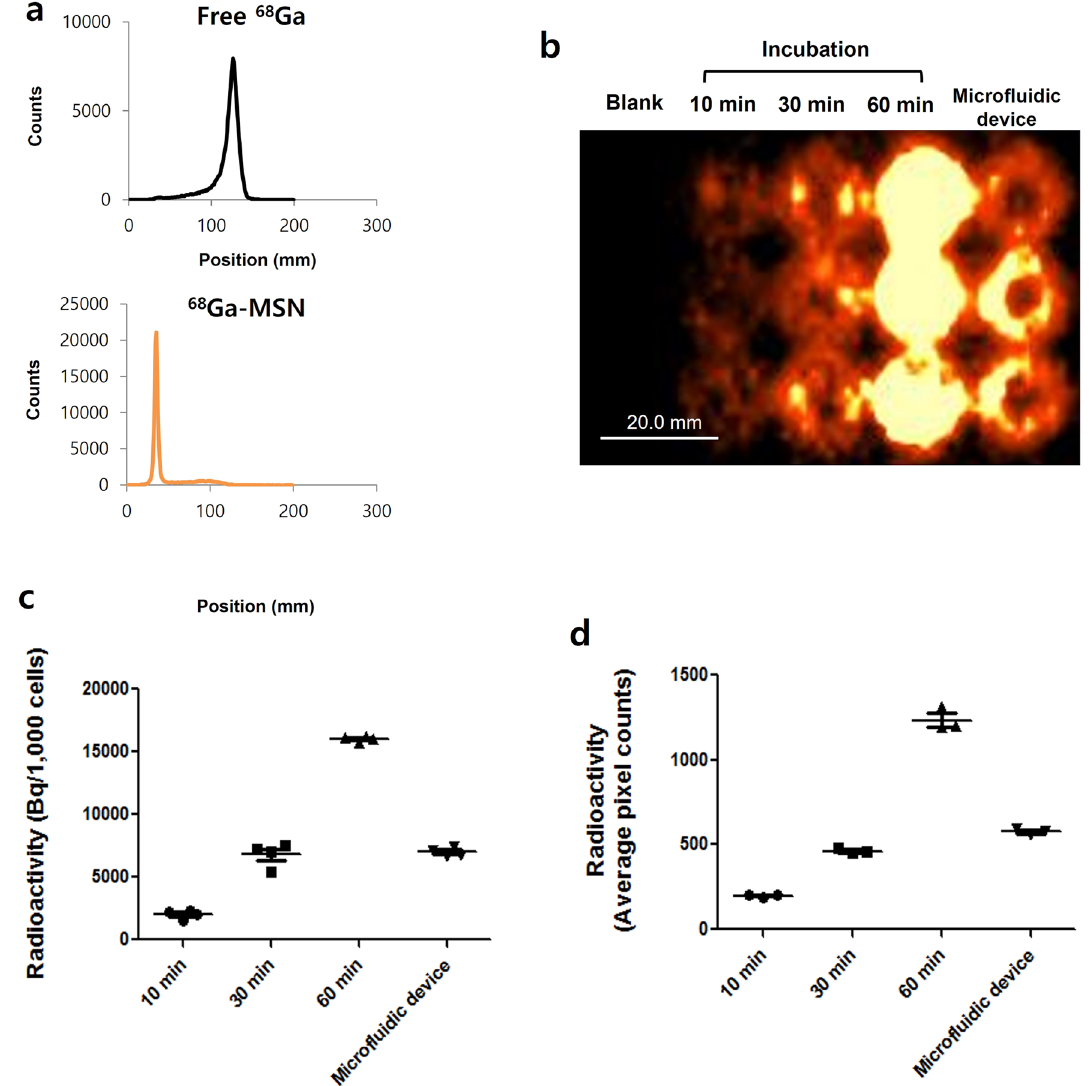
Figure 3. Cell radiolabeling using mechanoporation device. ( a ) Thin-layer chromatography showing efficient 68 Ga-labeling of MSNs. ( b ) PET images showing comparing cell labeling efficiency for passive transport (10 min, 30 min, and 60 min incubation) and microfluidic mechanoporation and ( c ) region-of-interest quantification of the images. ( d ) Gamma counting of the cell